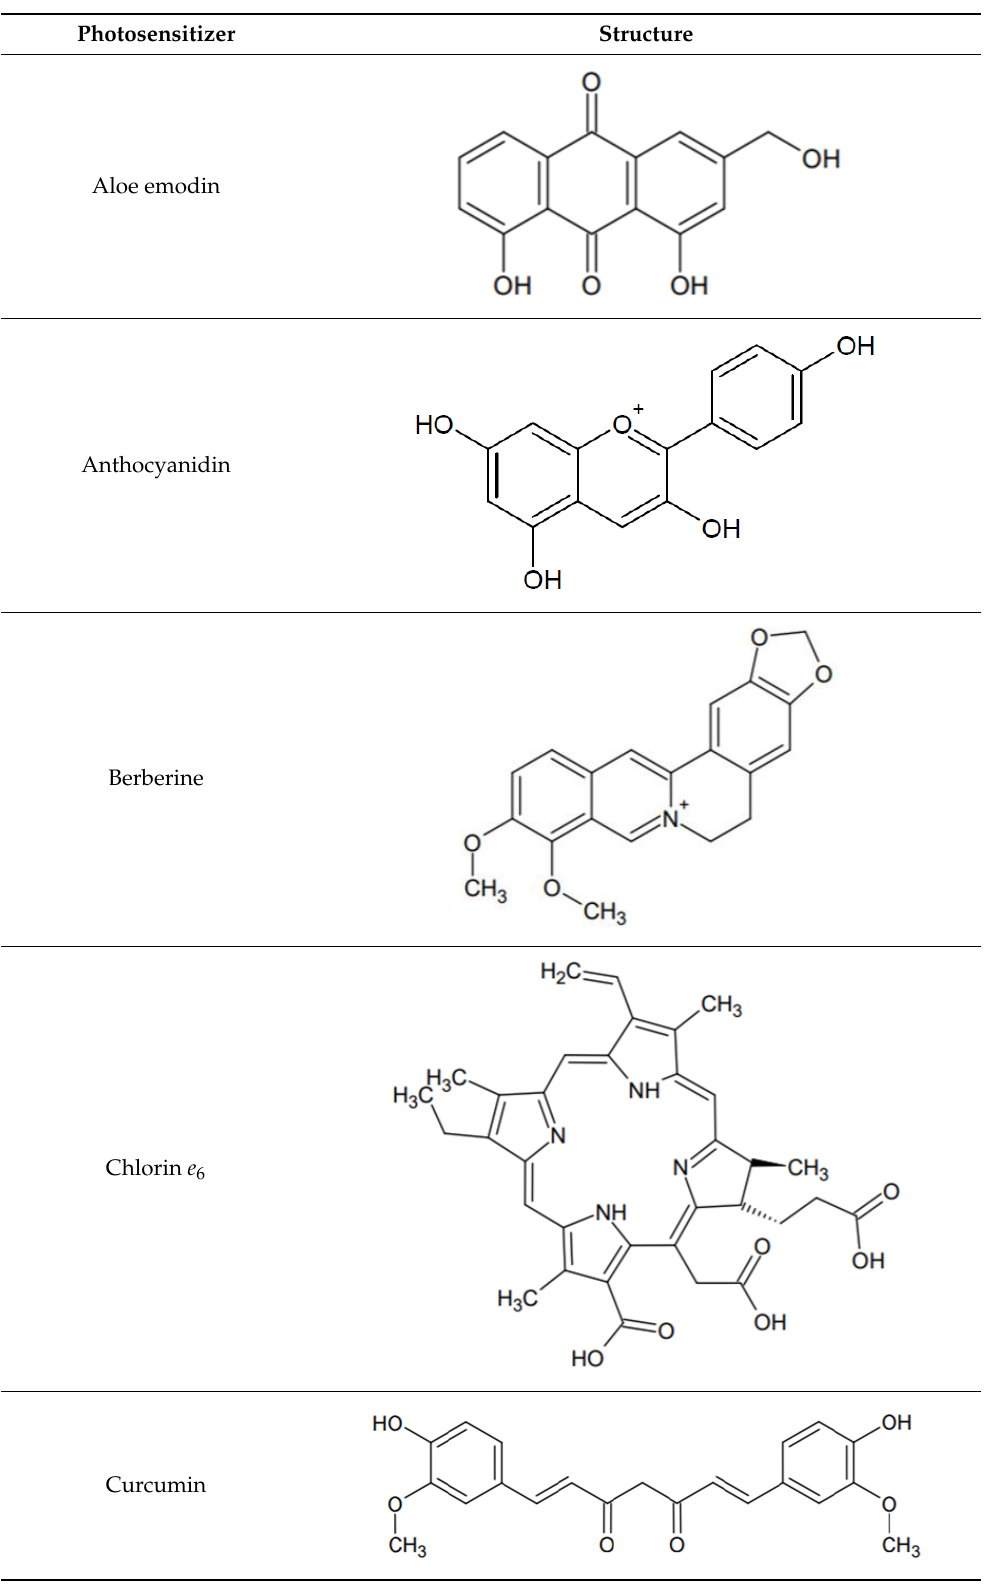
Table 2. Structures of selected photosensitizers from edible plants.